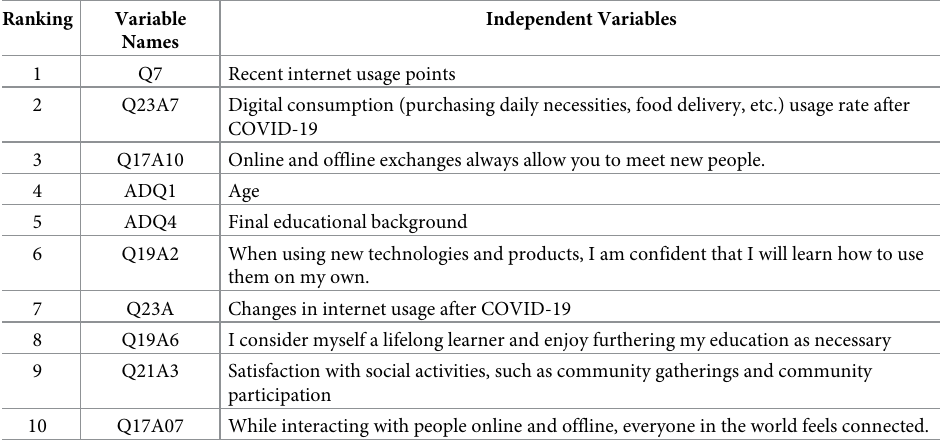
Table 3. Independent